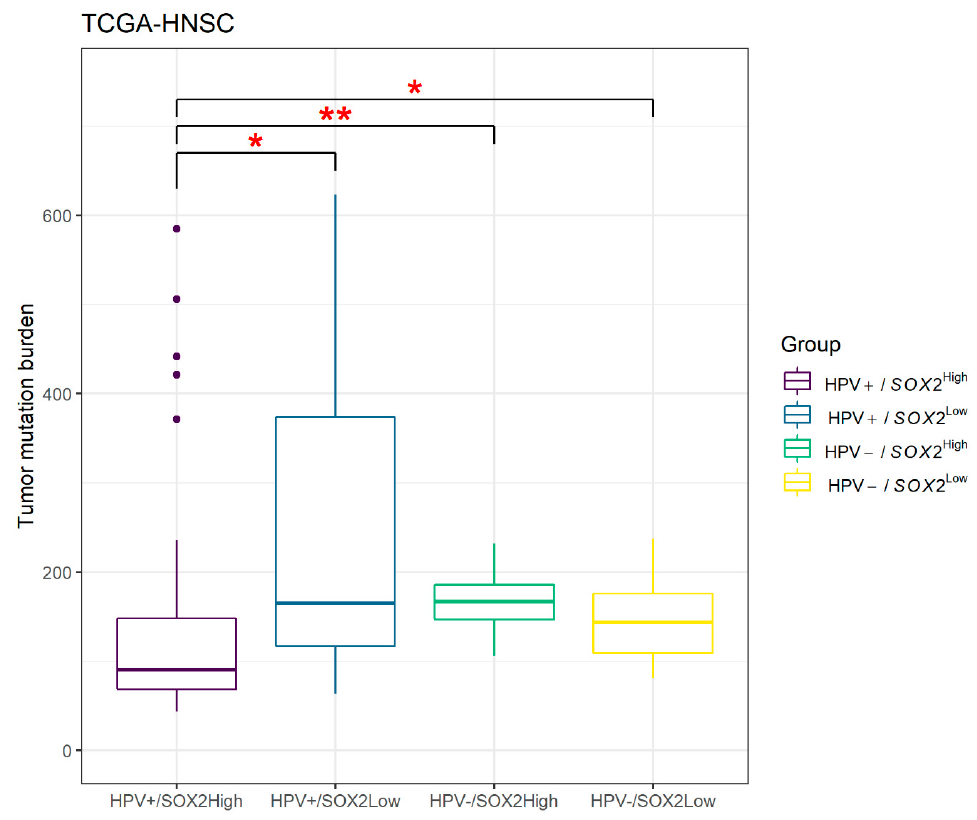
Figure 7. HPV+/ SOX2 High scored significantly lower tumor mutation burden (** p < 0.01; * p < 0.05). From the immune landscape of OPSCC in the TCGA-HNSC dataset (Figure S7), HPV+ cancers had a signi fi cantly higher rate of immune in fi ltration than HPV − cancers (83.7% vs. 16.3%, p = 0.001). Three markers, PD-1, PD-L1 and CTLA-4, related to immune therapy were not significantly different according to SOX2 expression in either HPV+ or HPV − oropharyngeal cancers (all p > 0.05) (Figure S8).